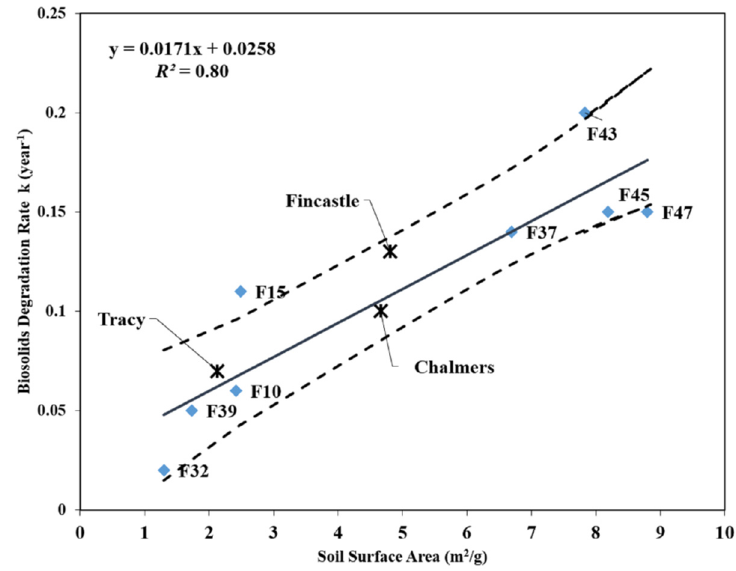
Figure 6. Biosolids degradation rate as a function of surface area for eight soils from different fields with 95% confidence interval. The three reference soils from Terry et al. [8] laboratory degradation experiments are also identified but not included in the correlation calculations.